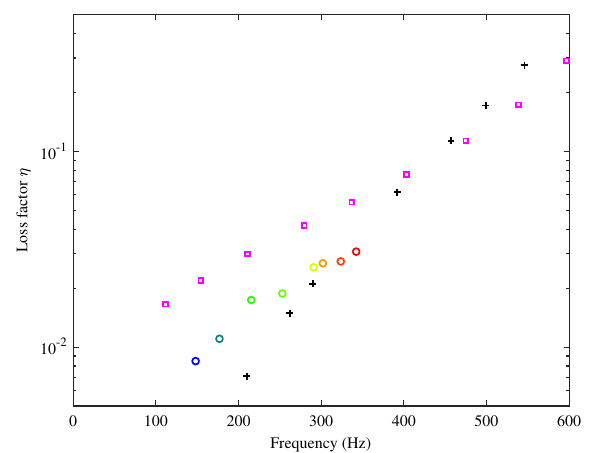
Figure 10. Loss factor against frequency for fi tted modes of selected examples of the variable tension set. Tensions are indicated by colour as in Figure 8. Circles and stars show results from separate